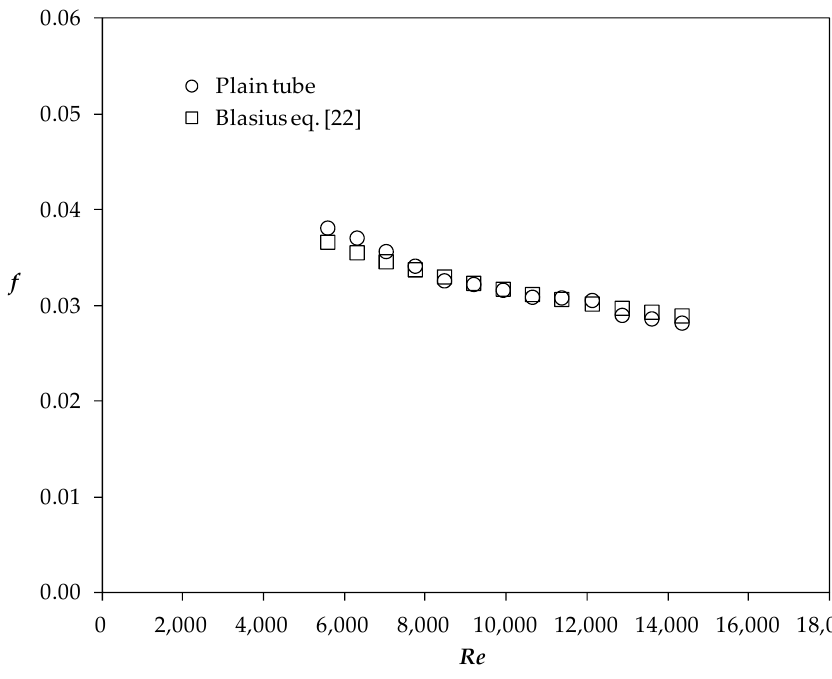
Figure 5. Validation of friction factor behavior of the plain tube.